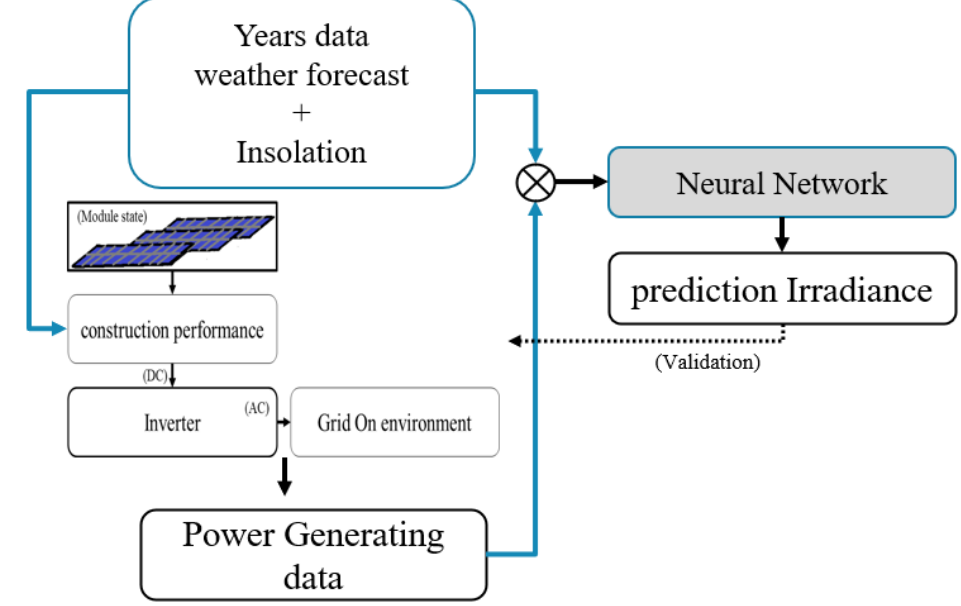
Figure 2. Schematic block diagram to predict irradiance from insolation and forecast date. Table 1. Seosan county’s ASOS dataset and calculate insolation to learn for building a model